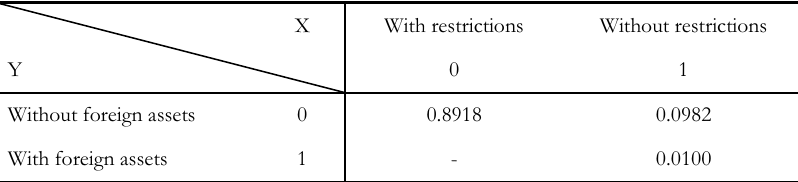
Latent class variable X and investment in foreign assets Y in Model 6 X With restrictions Without